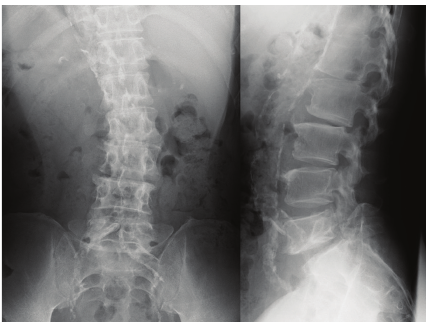
Figure1:Plainradiographsshowingadegenerativelumbarscoliosis andMeyerdinggradeIL5-S1isthmicspondylolisthesis2yearsbefore surgery.